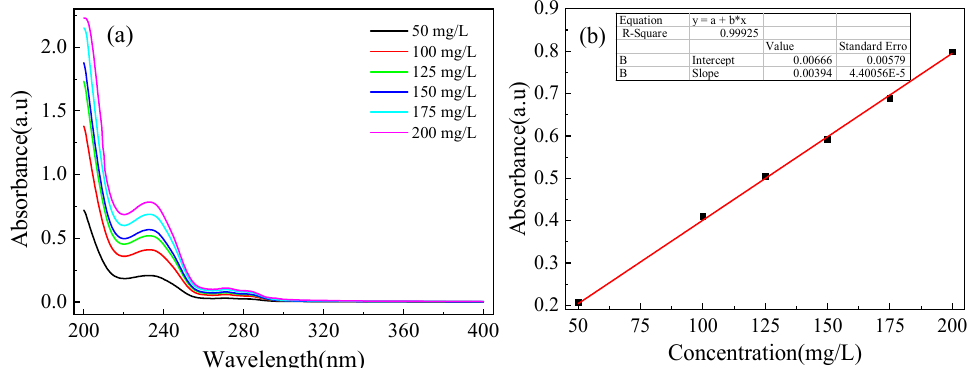
Figure 14. ( a ) UV–Vis spectra for different OIM solutions of known concentrations, and ( b ) the fitted standard curve of OIM . standard curve of OIM